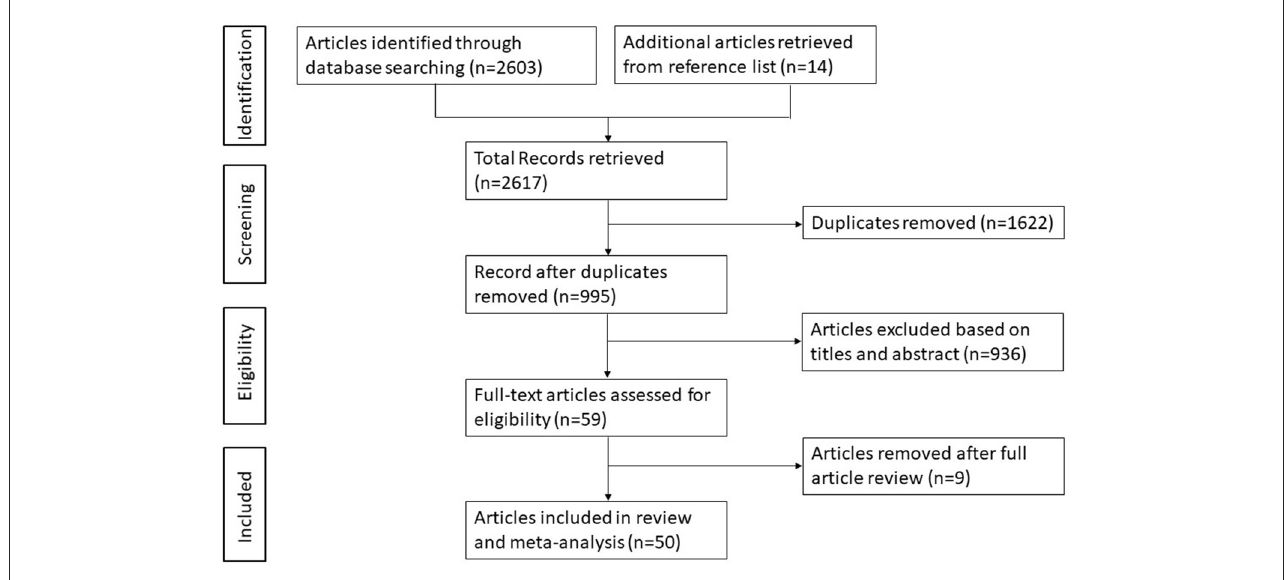
FIGURE1 A flow diagram of the search results and study